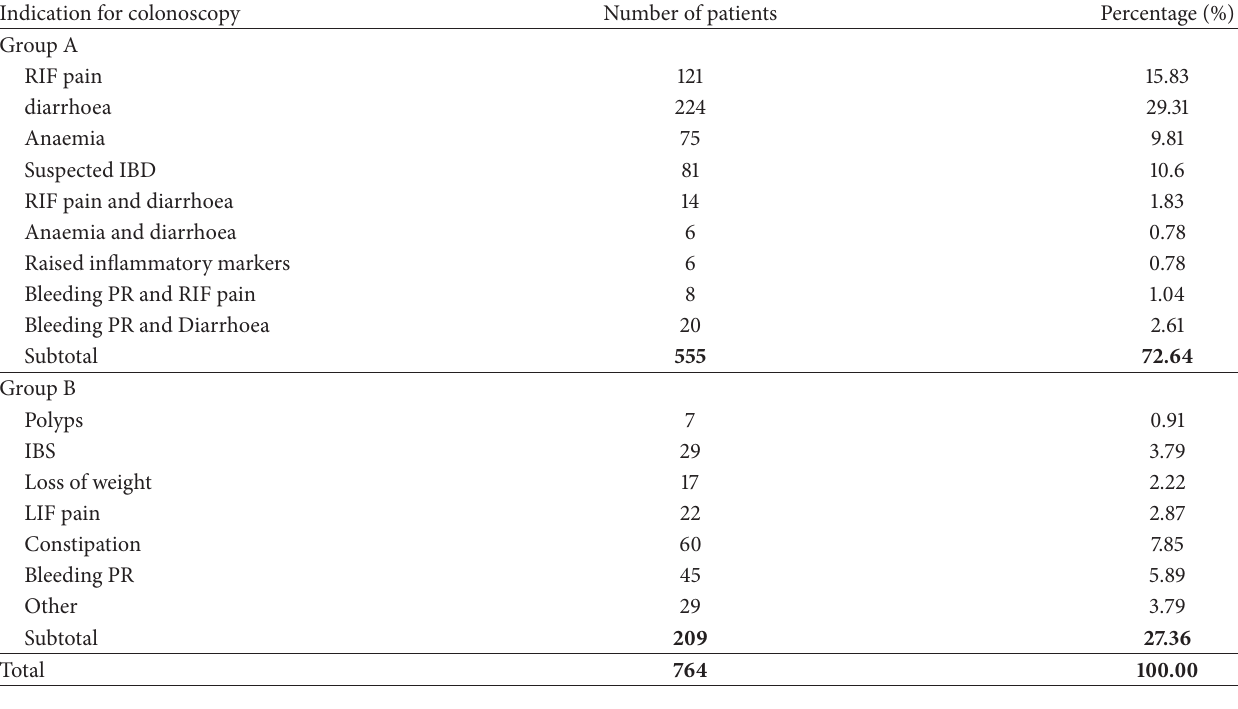
Table 1: Indications for colonoscopy.